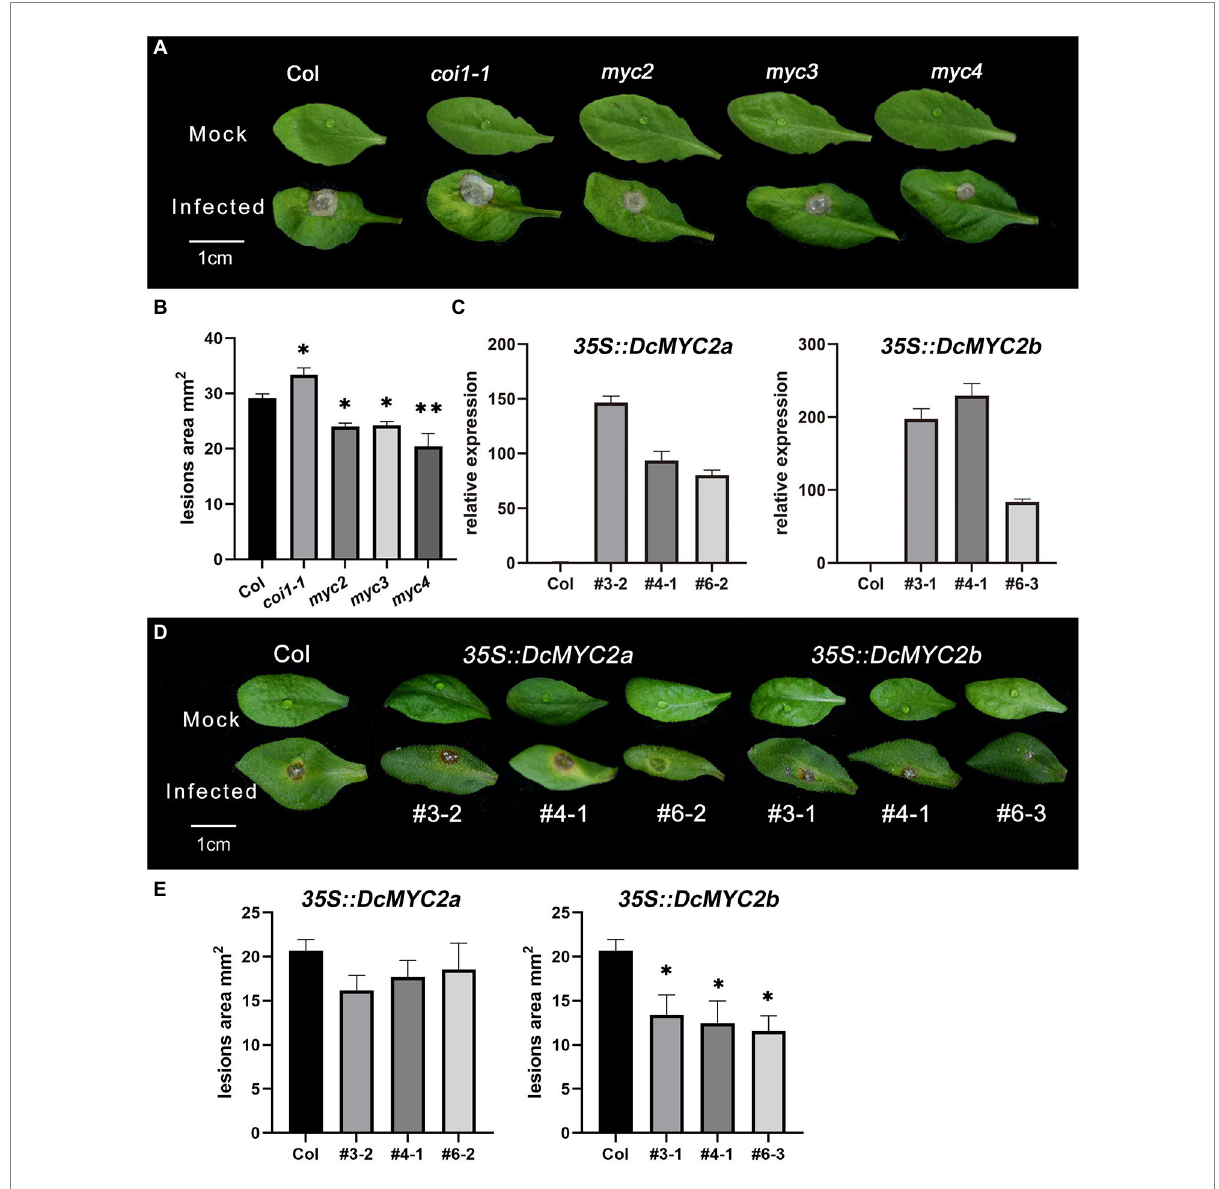
FIGURE 7 Functional validation of DcMYCs and AtMYCs genes. (A) Disease symptoms of leaves of Arabidopsis myc2 , myc3 , and myc4 mutants following inoculation with Sclerotium delphinii at 48 hpi. Bar = 1 cm. (B) Lesion size of leaves of Arabidopsis myc2 , myc3 , and myc4 mutants at 48 hpi. Significant difference (compared with the Col, * p < 0.05, ** p < 0.01). (C) Relative expression of DcMYCs in Arabidopsis DcMYCs -OE strain. The abscissa represents different lines of DcMYCs -OE. (D) Disease symptoms of leaves of Arabidopsis DcMYC2a/2b -OE at 48 hpi. Bar = 1 cm. The # represents different lines. (E) Lesion size of leaves of Arabidopsis DcMYC2a/2b -OE at 48 hpi. The * shows a significant difference at p < 0.05 compared with the